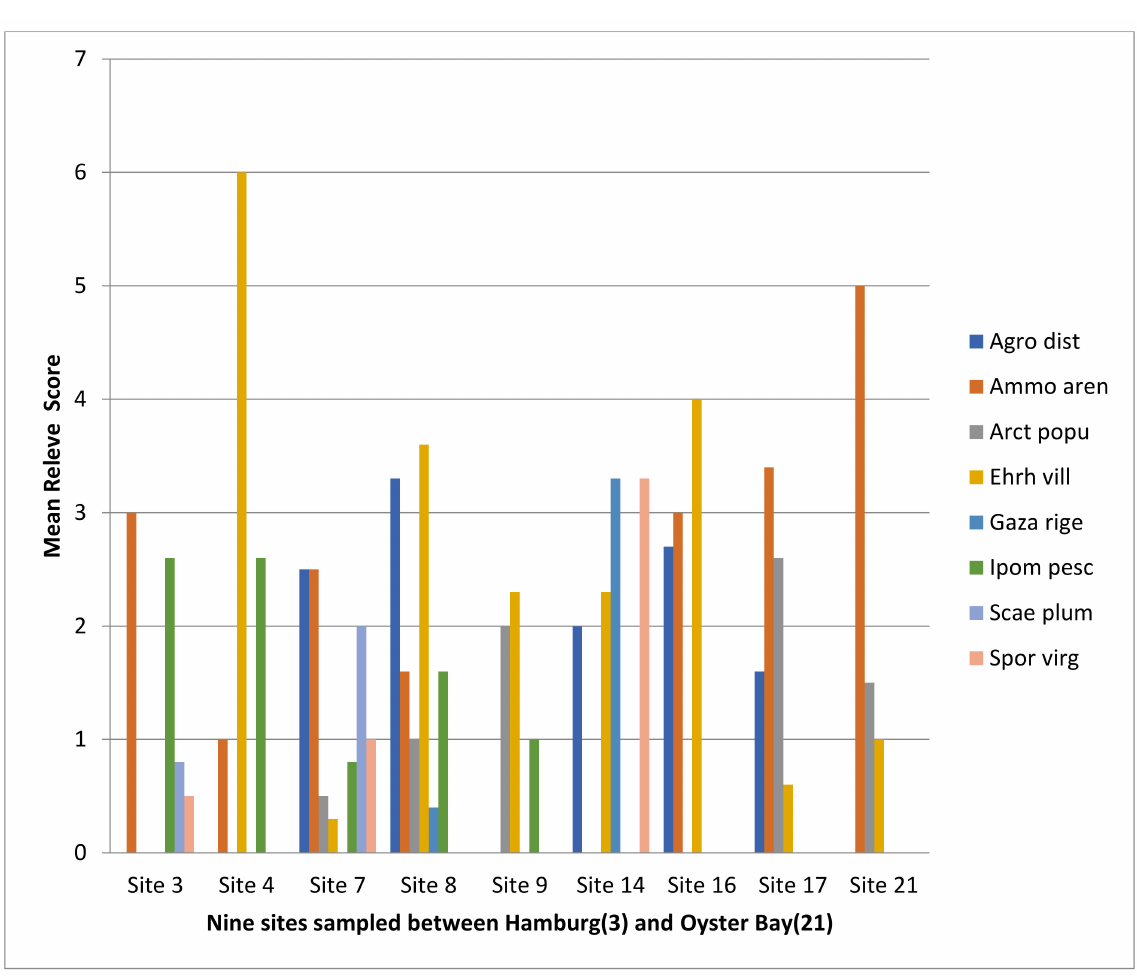
Figure 2. Abundance of Ammophila arenaria (marram grass) and seven other pioneer dune species sampled in 9 sites along the Eastern Cape coast. (Site 3 = Hamburg; 4 = Mtati Mouth, 7 = Kleinemonde; 8 = Port Alfred; 9 = Kenton; 14 = Port Elizabeth, Summerstrand; 16 = Sardinia Bay; 17 = Paradise Beach; 21 = Oyster Bay. For full names of species, see Table 3 above and in the text.). The mean number of pioneers in the sites sampled was two (Table 3) and the highest number of pioneer species was found in site 7 (Kleinemonde) with seven species, only Gazania rigens being absent at that site. The number of pioneer species in the relev é s ranged from one to five and there was a range of abundance in the relev é s (Figure 2). There were also a few secondary species in some of the relev é